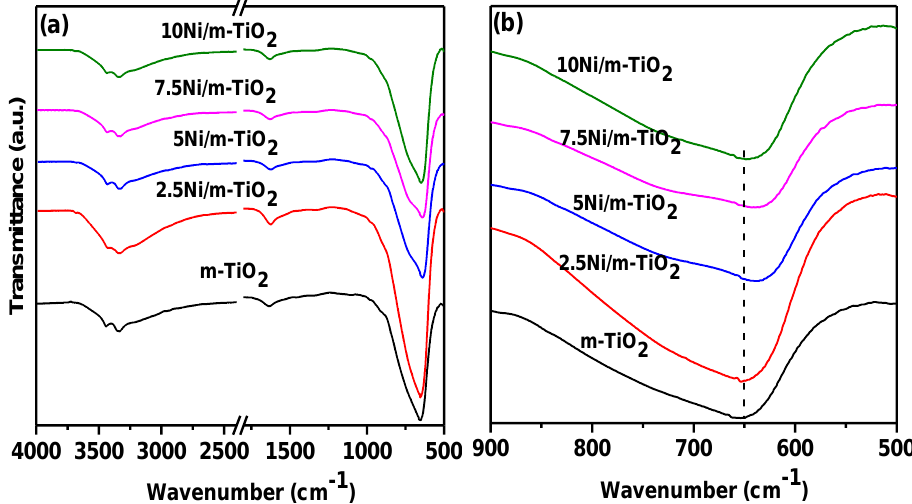
Figure 2. FT-IR spectra of synthesized xNi/m-TiO 2 catalysts (x-2.5, 5, 7.5, and 10 wt.%) ( a ) 4000–500 cm − 1 range and ( b ) 900 to 500 range cm − 1 .